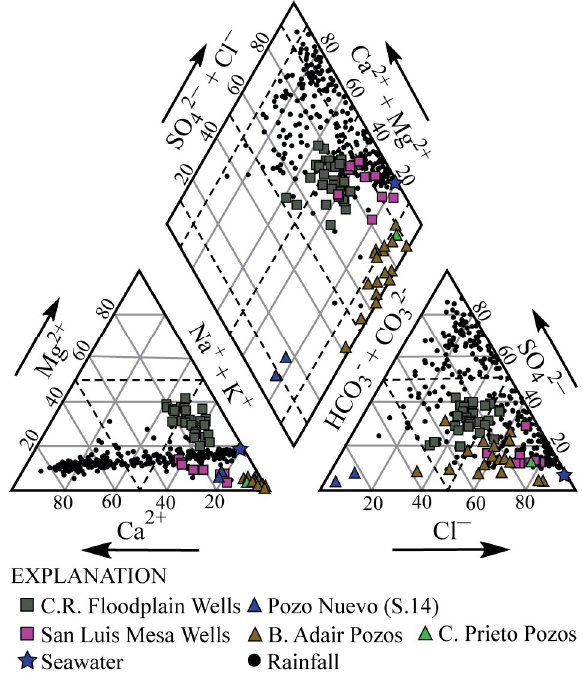
Figure 5. Piper diagram showing data for rainfall samples collected at the Organ Pipe Cactus National Monument (OPCNM), Colorado River (C.R.) floodplain well samples, San Luis Mesa well samples, and pozos water samples. Bicarbonate was used to balance the charge among major ions where it was not reported.